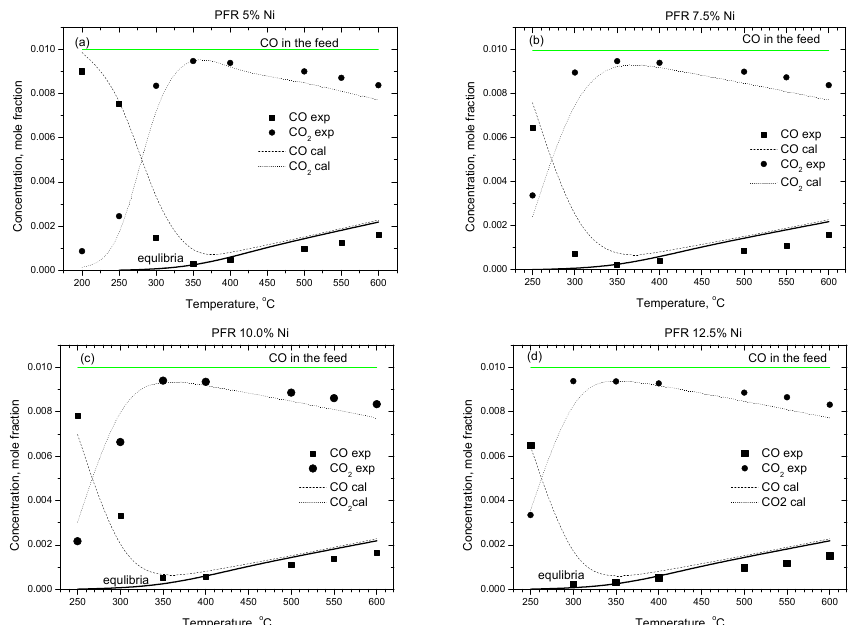
Figure 6. Comparison of experimentally determined (symbols) and numerically predicted (lines) mole fractions as a function of temperature for WGS in a fixed-bed reactor: ( a ) 5% Ni/CeO 2 ; ( b ) 7.5% Ni/CeO 2 ; ( c ) 10% Ni/CeO 2 ; ( d ) 12.5% Ni/CeO 2 , solid lines = equilibrium composition at given temperatures for 1% CO + 1.8% H 2 O in He.